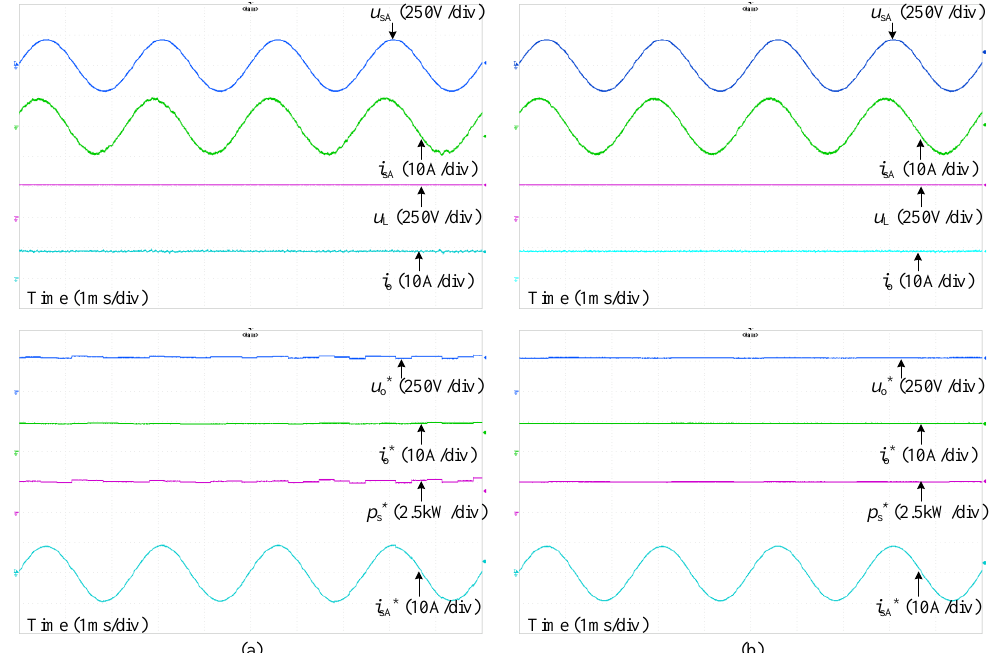
Figure 6. Steady-state experimental waveforms of source voltage u sA , source current i sA , load voltage u L , output current i o , reference output voltage u o *, reference output current i o *, reference source active power p s * and reference source current i sA *: ( a ) the output sampling time T so was 333 s; and ( b ) T